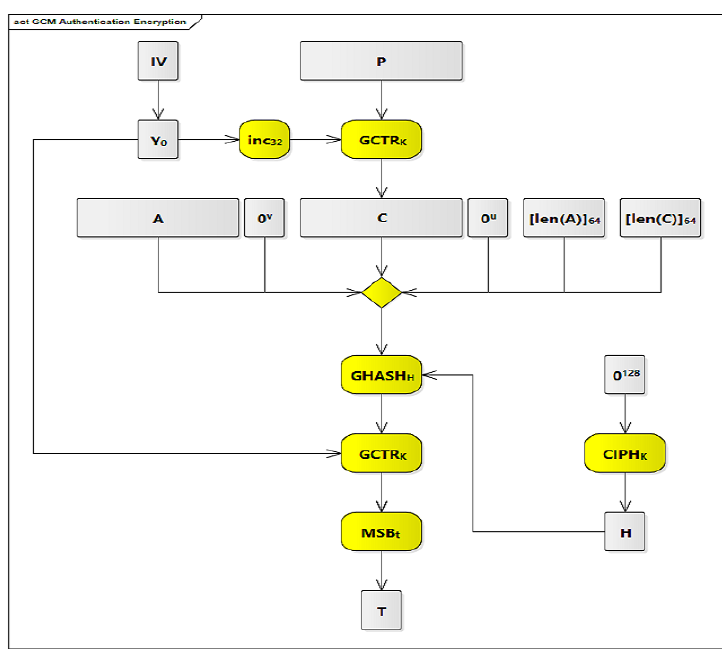
Figure 5. GCM authentication encryption.